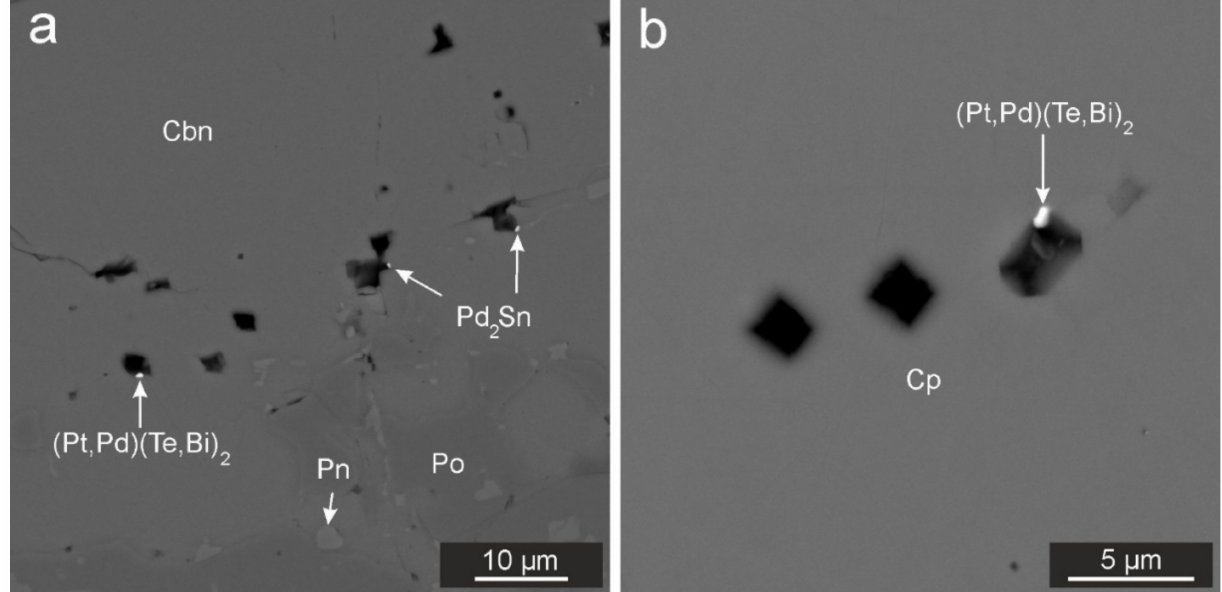
Figure 12. Fluid inclusions in the sulfide ores of the Talnakh deposit. ( a ) Large group of fluid inclusions in cubanite; ( b ) Chain of euhedral fluid inclusions in chalcopyrite. BSE images. Abbreviations: Cbn—cubanite; Pn—pentlandite; Po—pyrrhotite; (Pt,Pd) (Te,Bi) 2 —moncheite; Pd 2